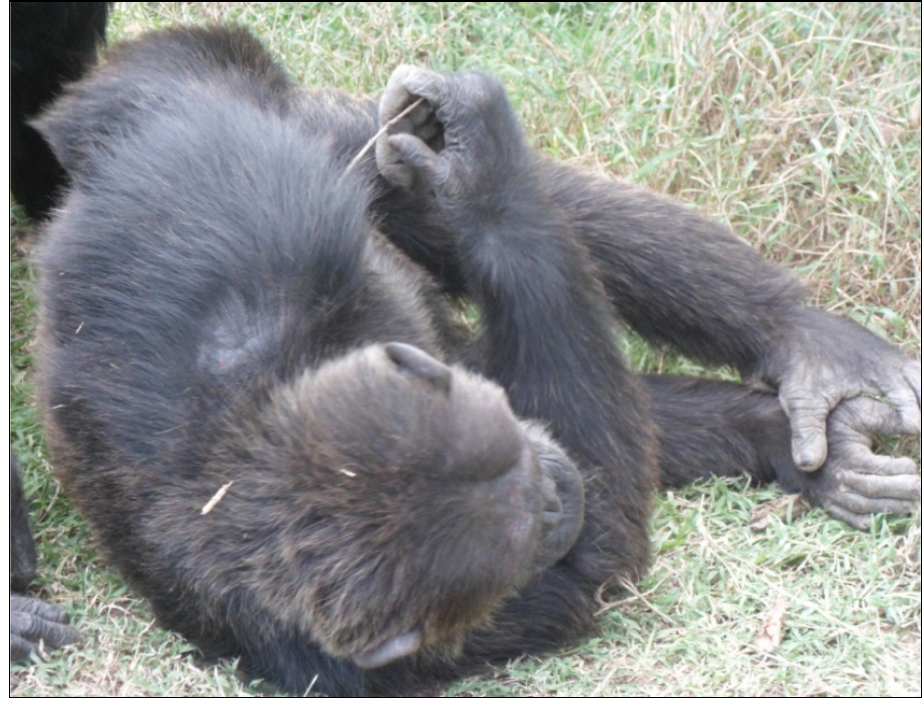
Figure 6. Safari poking himself with a stick in the arm.